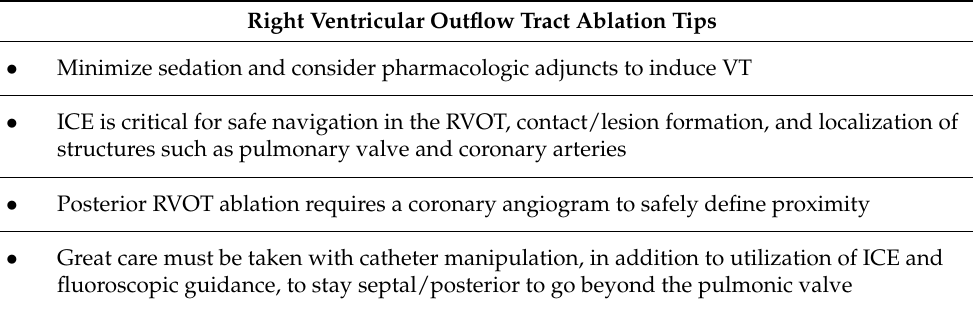
Table 1. Summary of RVOT ablation